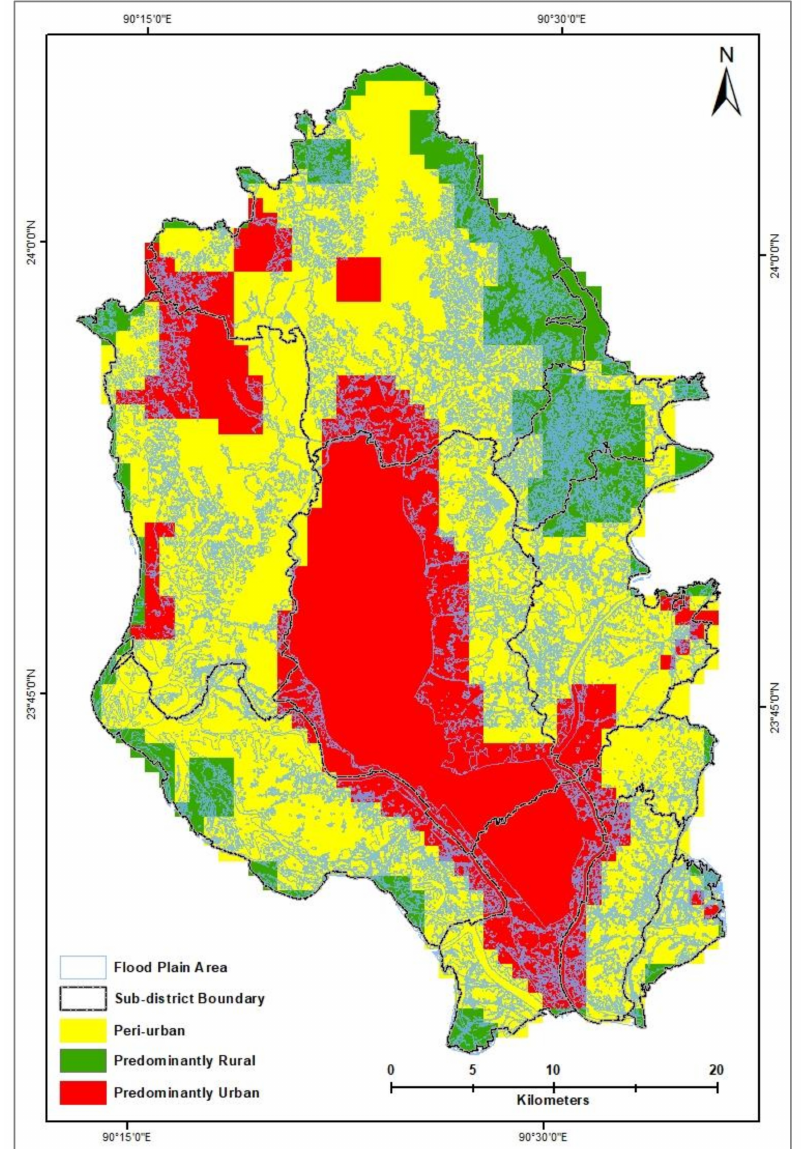
Figure 16. DMDP’s flood plain area (FPA) (derived from CRDP [60]) superimposed on the VIIRTS NTL data mapping of